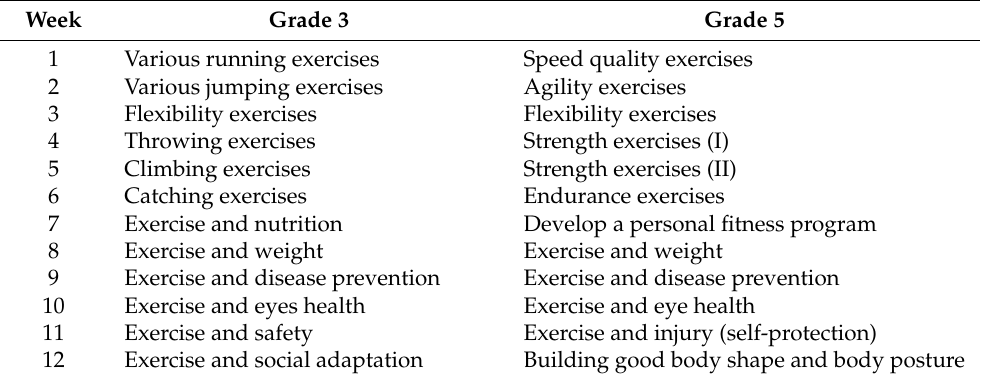
Figure 4. Contents of the flipchart for the second week of the fifth grade. Sensitivity practice topics (introduction to what is meant by sensitivity, demonstration of various forms of sensitivity practice, knowledge of safety and protection). Table 4. Phases of the intervention